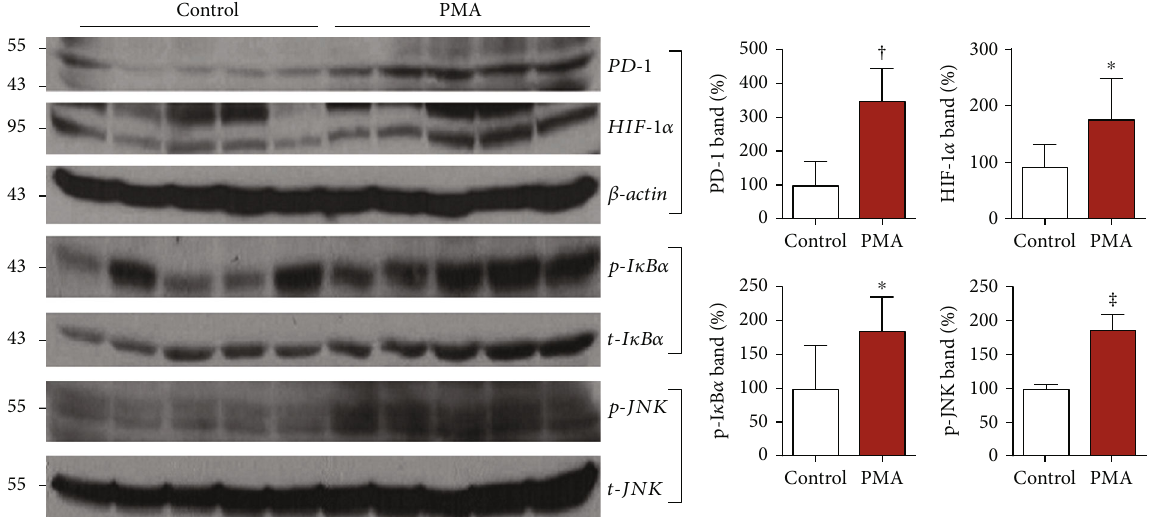
Figure 8: E ff ects of PMA on signaling pathways in EL4 tumors. Immunoblots of tumor tissue for PD-1, HIF-1 α , p-I κ B α , and p-JNK with quanti fi ed protein band intensities corrected by controls. Animals were intraperitoneally administered with vehicle or PMA for 3 days. Bars represent the mean ± SD of quintuple mice per group. ∗ P < 0 : 05 , † P < 0 : 005 , and ‡ P < 0 : 001